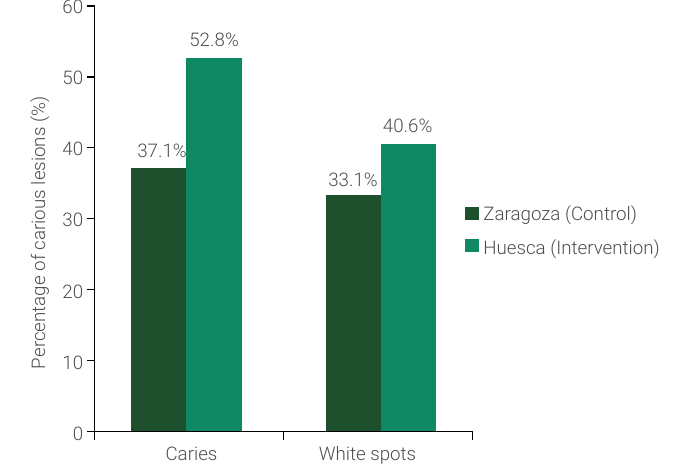
Figure B. Prevalence of caries and white spots assessed in the first permanent molars of 7 to 11-year- olds in the post-intervention period (T3), in Zaragoza and Huesca, Spain,